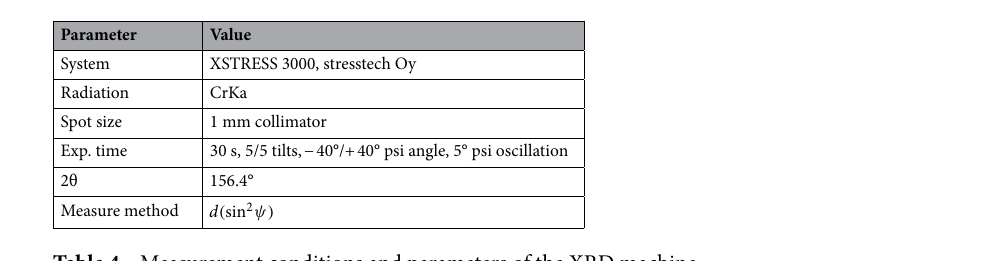
Table 4. Measurement conditions and parameters of the XRD